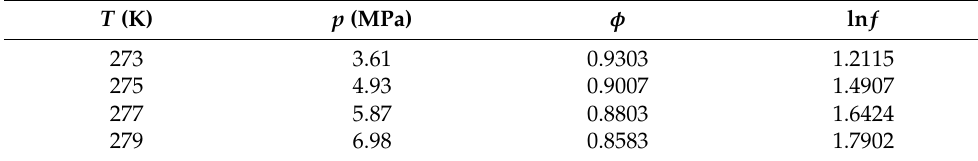
Table 2. State data of the jump pressure at different temperatures.